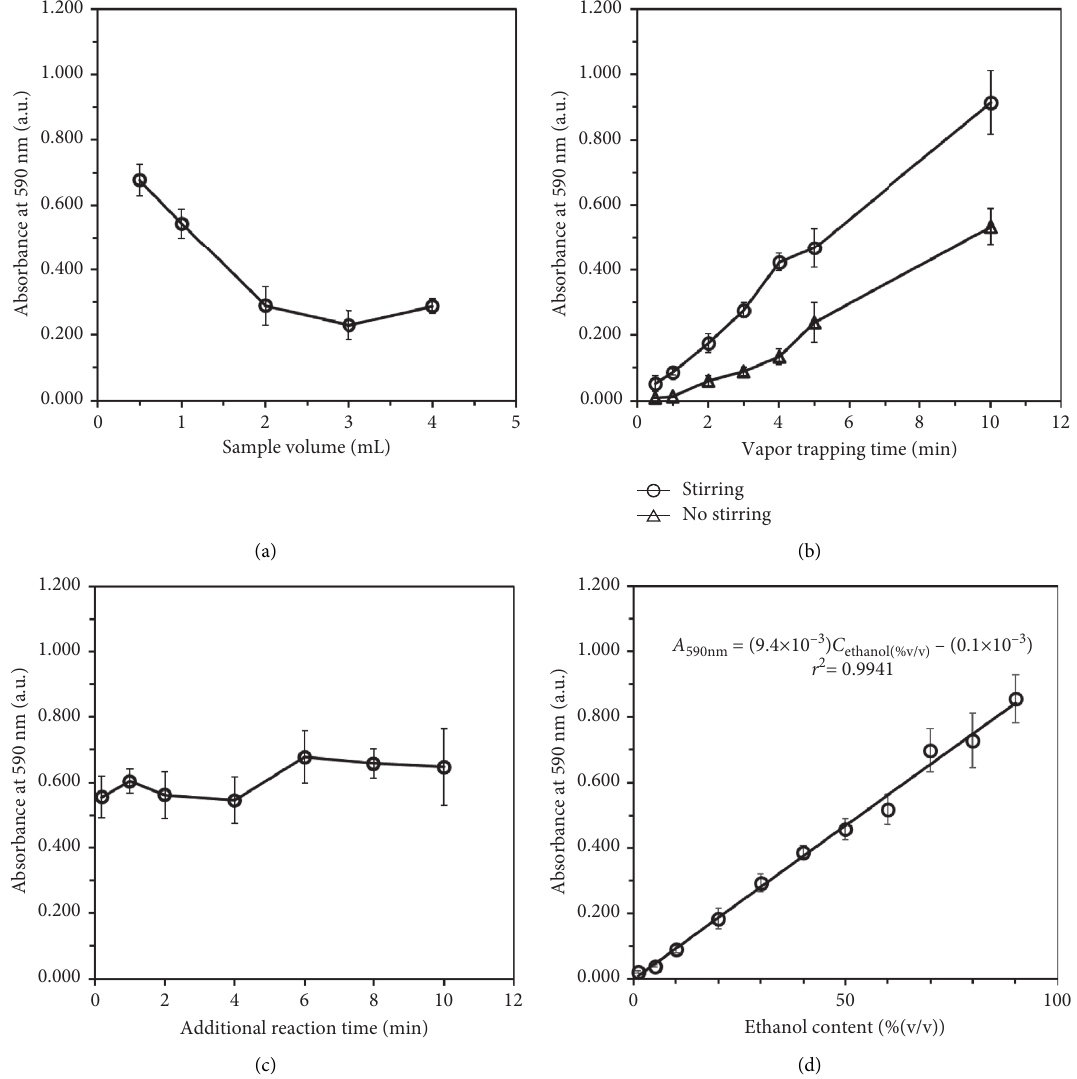
Figure 2: Optimization results of the effect of sample volume (a), vapor trapping time (b), additional reaction time before absorbance measurement (c), and linearity of the proposed MBL-VP unit for colorimetric determination of ethanol